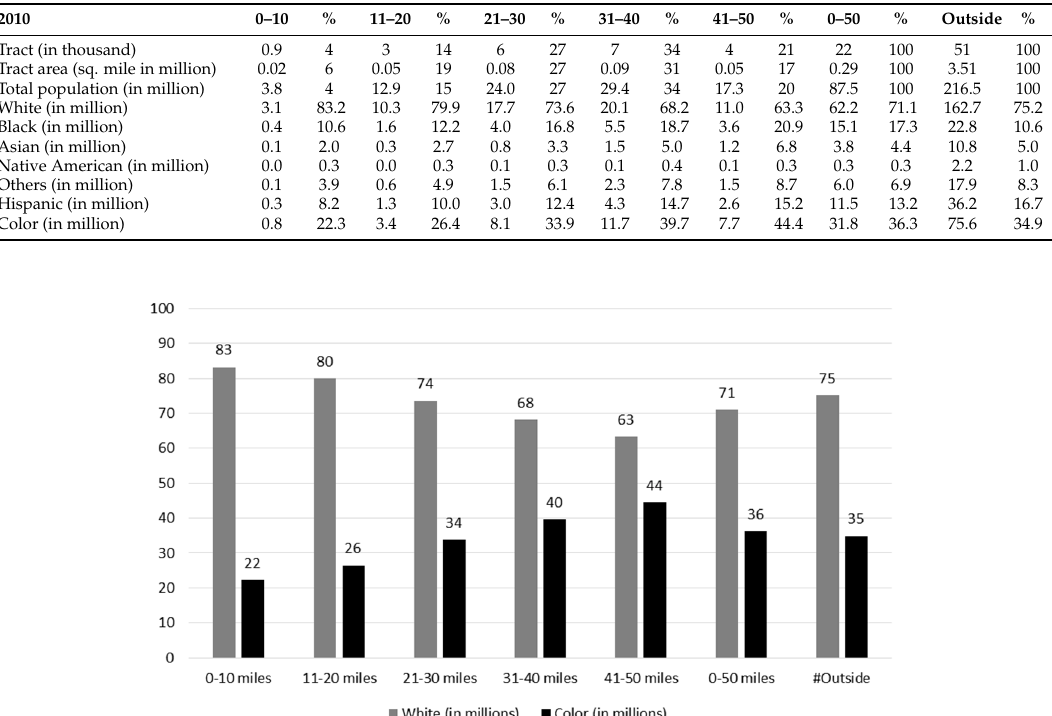
Table 1. Demographic composition according to area, sorted by distance from any one of the 61 commercial NPPs, based on 2010 American Community Survey data.